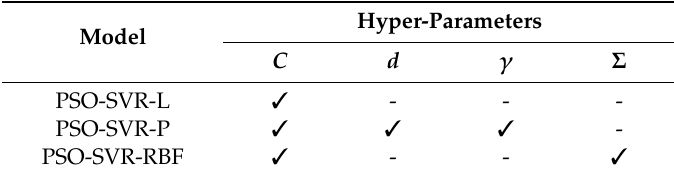
Table 3. Hyper-parameters of the SVR models with the different kernel functions.